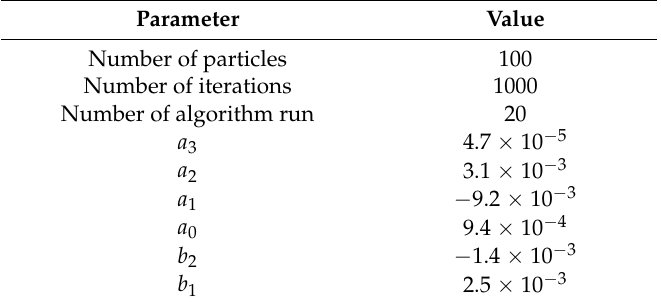
Table 4. Optimized values for the parameters of the forecasting